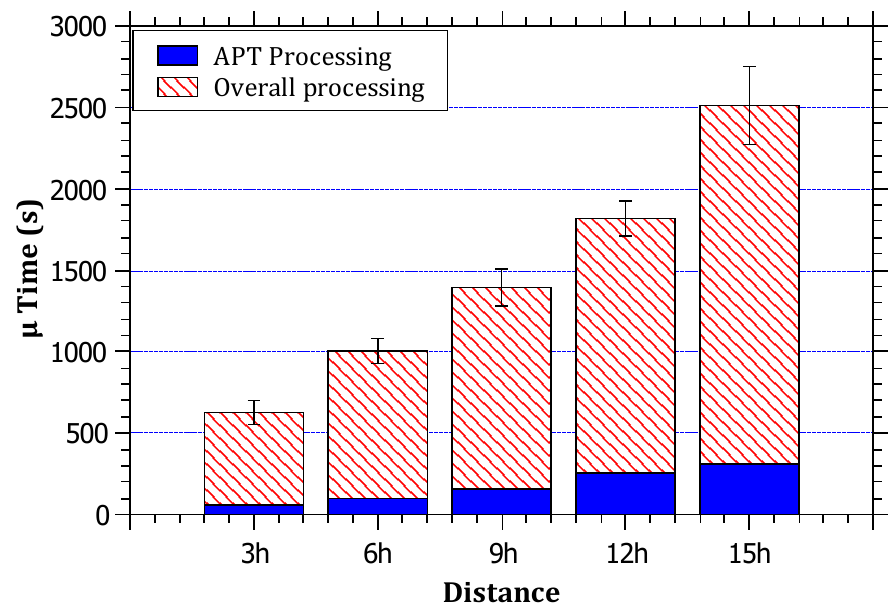
Figure 10. The relationship between the distance of the attack and the ratio of RAPT algorithm processing time to the total simulation processing